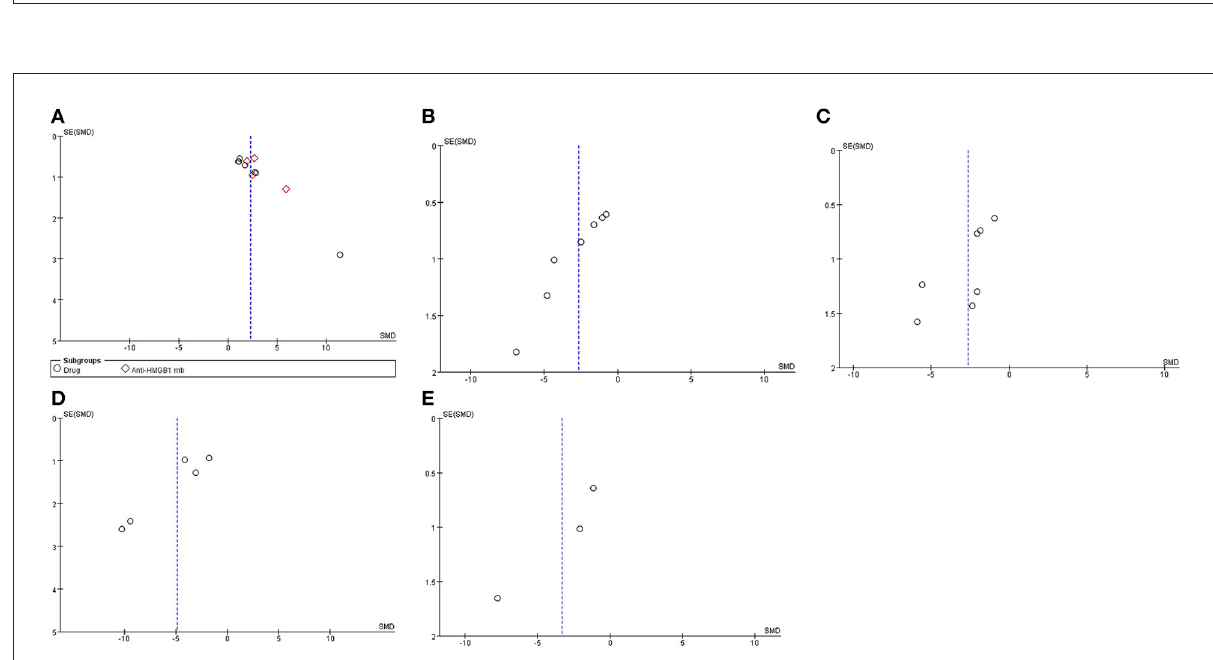
FIGURE8 Asymmetries found in the funnel plots indicated the possibility of publication bias. Funnel plots of publication bias for locomotor function score (A) , HMGB1 levels (B) , TNF- α levels (C) , water content (D) , and apoptosis (E)